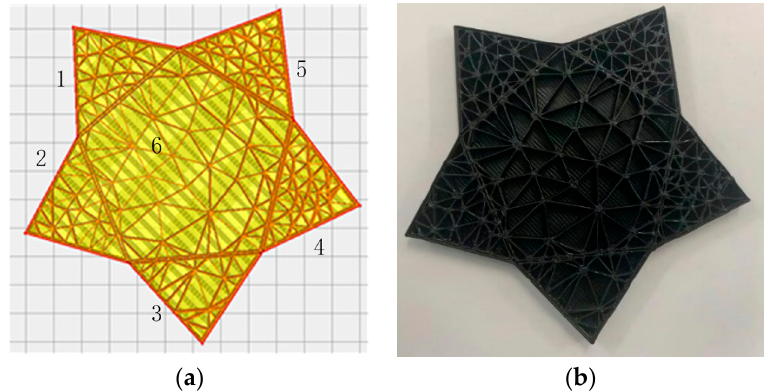
Figure 10. Variable density filling experiment based on Delaunay triangulation. ( a ) Filling software